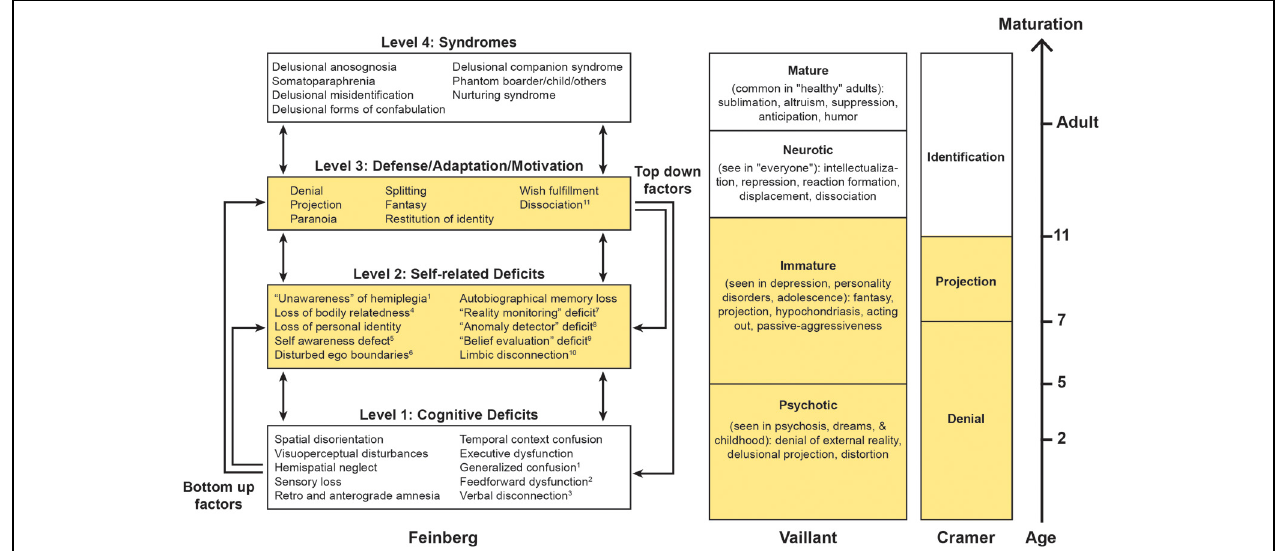
FIGURE 1 | Based upon Feinberg (2010, 2011a); Vaillant (1977, 1992, 1993) and Cramer (1991, 2006). On the left is a hierarchical four-tiered model of representative factors contributing to some of the neuropathologies of the self. Some cognitive (level 1) deficits are specifically linked to certain syndromes, while self-related deficits and positive features may be applied to many syndromes. A temporal dimension emerges as syndromes evolve from the interaction of multiple lower level negative and higher level positive factors. This model is compared with the hierarchical model of the defenses proposed by Vaillant (1977, 1992, 1993) and the developmental model of Cramer (1991, 2006). Areas in yellow represent the corresponding immature